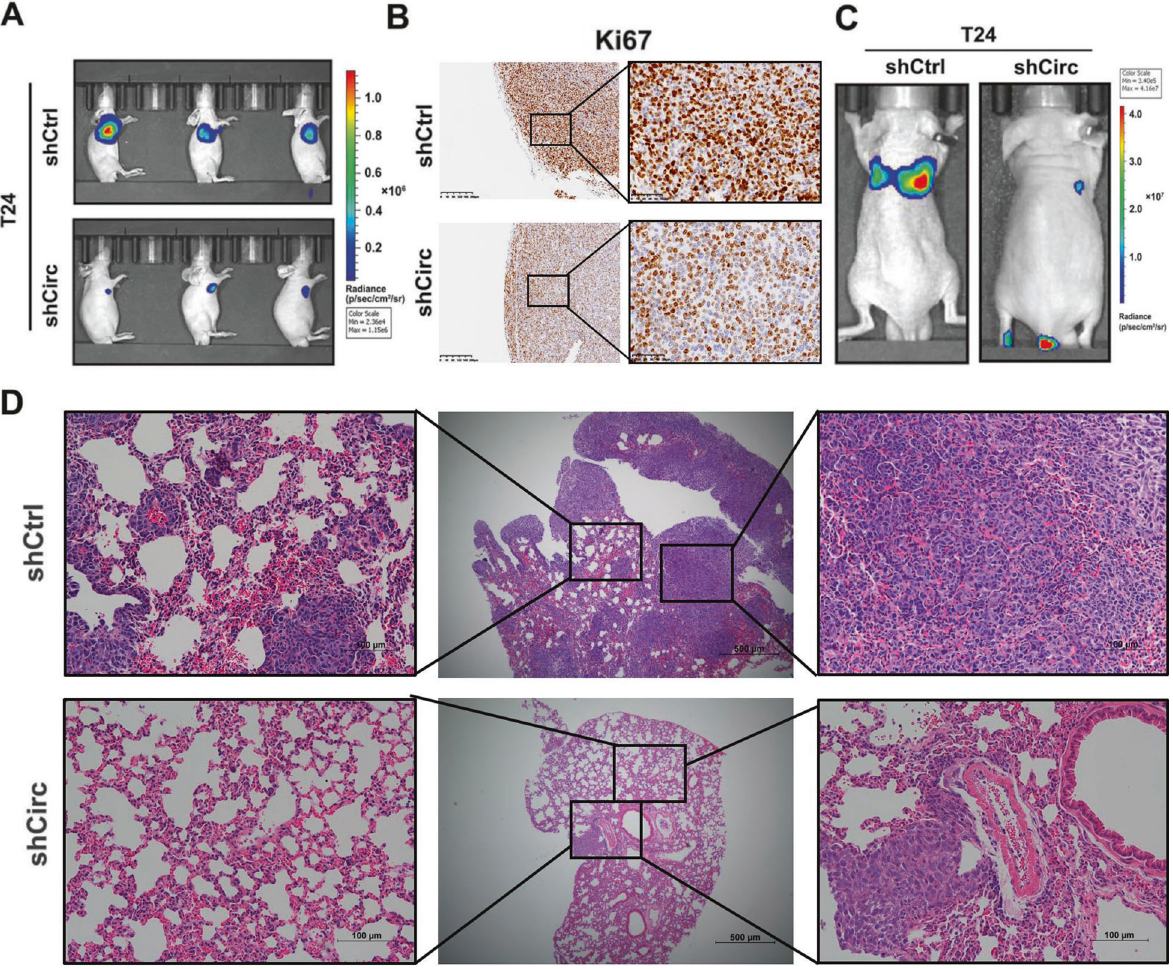
Fig. 3 Silencing hsa_circ_0007813 suppressed proliferation, migration, and invasiveness potentials of bladder cancer cells in vivo. A Luciferase expressing T24 transfected with control shRNA (shCtrl) and shRNA (shCirc) were used to establish subcutaneous xenograft models. In vivo bioluminescence imaging was used to monitor tumor growth ( P < 0.05, N = 3, Kruskal – Wallis test). B Ki67 IHC staining of tumor tissues dissected from subcutaneous xenograft models (Scale bars represent 100 μ m). C Bioluminescence imaging of mice metastasis models ( N = 1). D Representative H&E-stained slices of lungs taken from shCtrl and shCirc bearing mice (Scale bars in the second column represent 500 μ m; Scale bars in the fi rst and third columns represent 100 μ m). All error bars in the fi gures indicated the standard deviation of